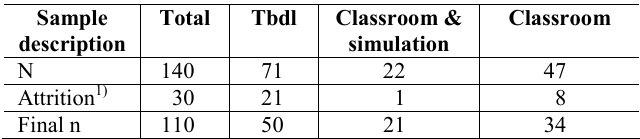
Table 1: Initial sample